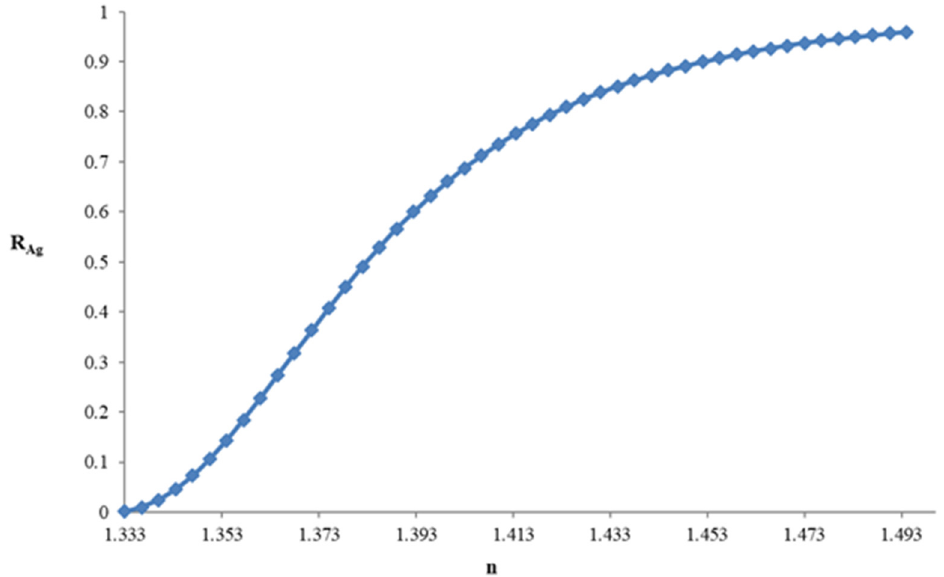
Figure 3. Reflectance curve vs. refractive index of the sucrose solution. The reflectance curves vs. the concentration of sucrose are shown in Figure 4. We have used data from [19].